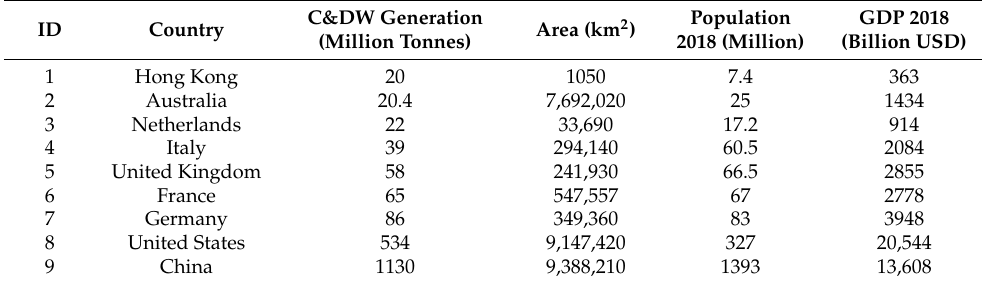
Table 3. C&DW generation worldwide